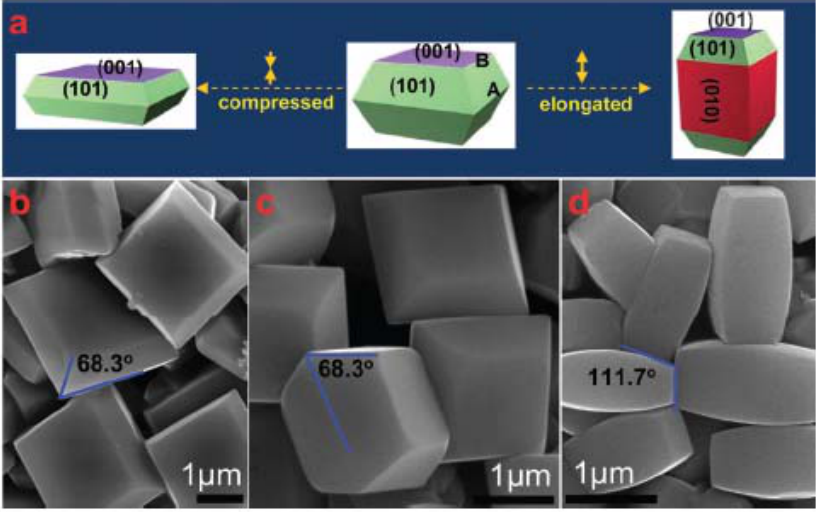
Figure 16. ( a ) Scheme of anatase TiO crystals with different percentages of {101}, {001} 2 and {010} facets; ( b–d ) SEM images of anatase crystals synthesized with different hydrofluoric acid aqueous solutions (120, 80 and 40 mM) containing different amounts of TiOSO precursor (64, 32 and 32 mg) at 180 °C for different times (12, 12 and 2 h). 4 Reprinted from ref. [109] with permission of Wiley.